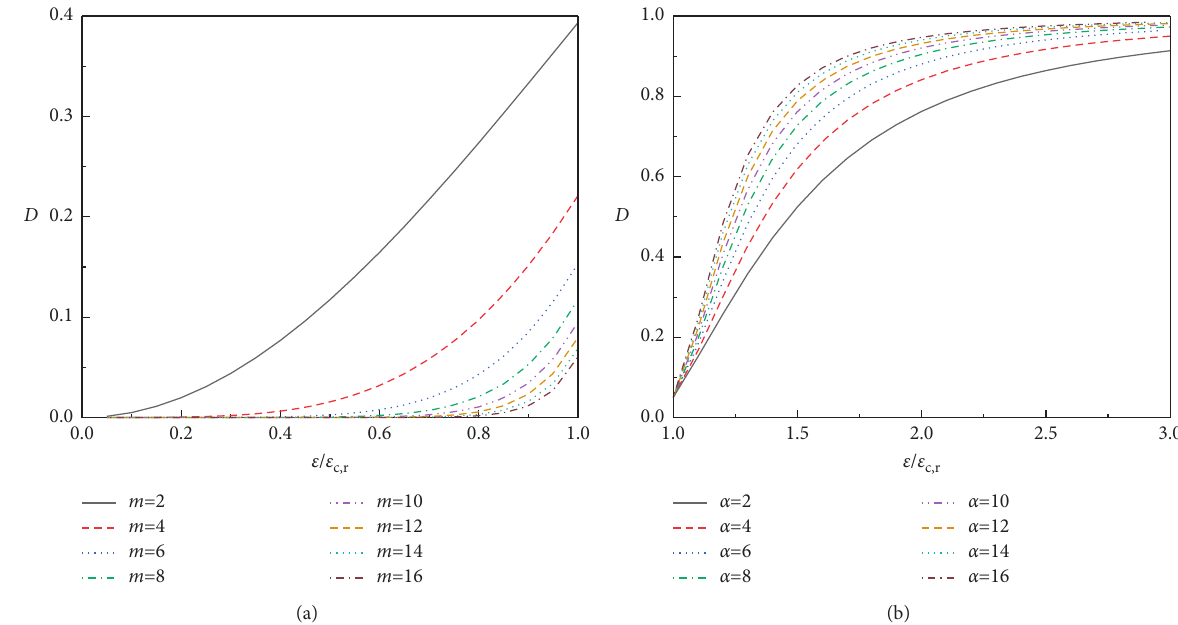
Figure 7: Relationship between strain rates and D under different value of (a) m and (b) α